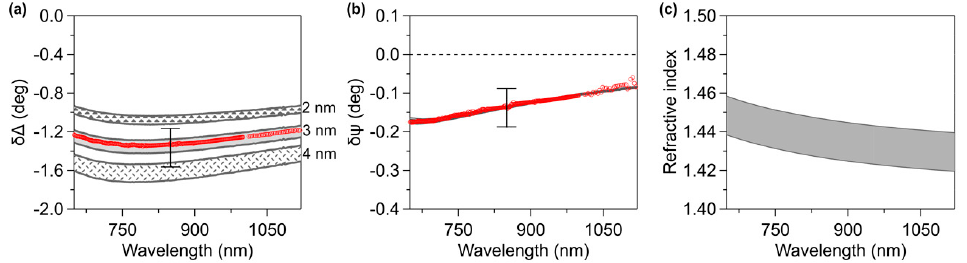
Figure 5. ( a,b ) Comparison between NIR SE δ -data for C 6 -ssDNA prepared in 1 M NaCl buffer (red circles) and simulations (grey lines). Areas decorated with different motifs represent, for d film = 2 nm, 3 nm and 4 nm, simulations with Cauchy A-coefficient values comprised between 1.41 (top border) and 1.43 (bottom border), B = 0.012 µm 2 . Error bars take into account the sample to sample variability. ( c ) Refractive index referred to simulations with d film = 3 nm, B = 0.012 µm 2 and A-coefficient values comprised between 1.43 (top border) and 1.41 (bottom border).